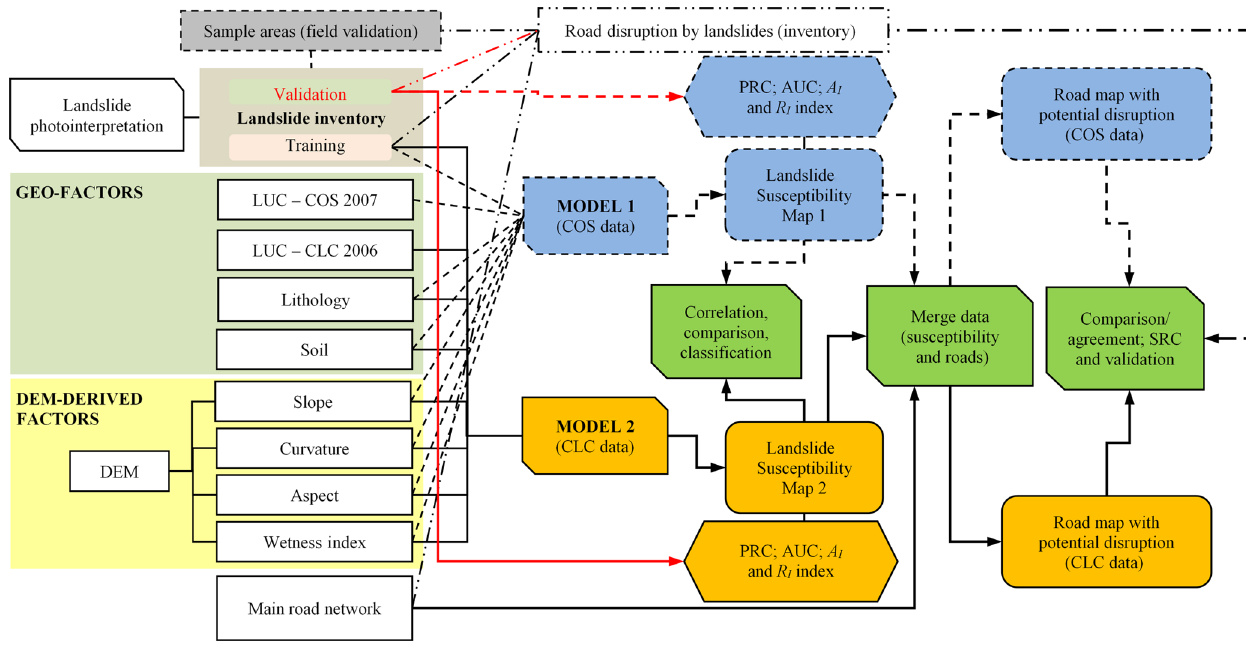
Figure 4. Workflow of landslide susceptibility assessment (using different LUC datasets) and the road susceptibility data integration.